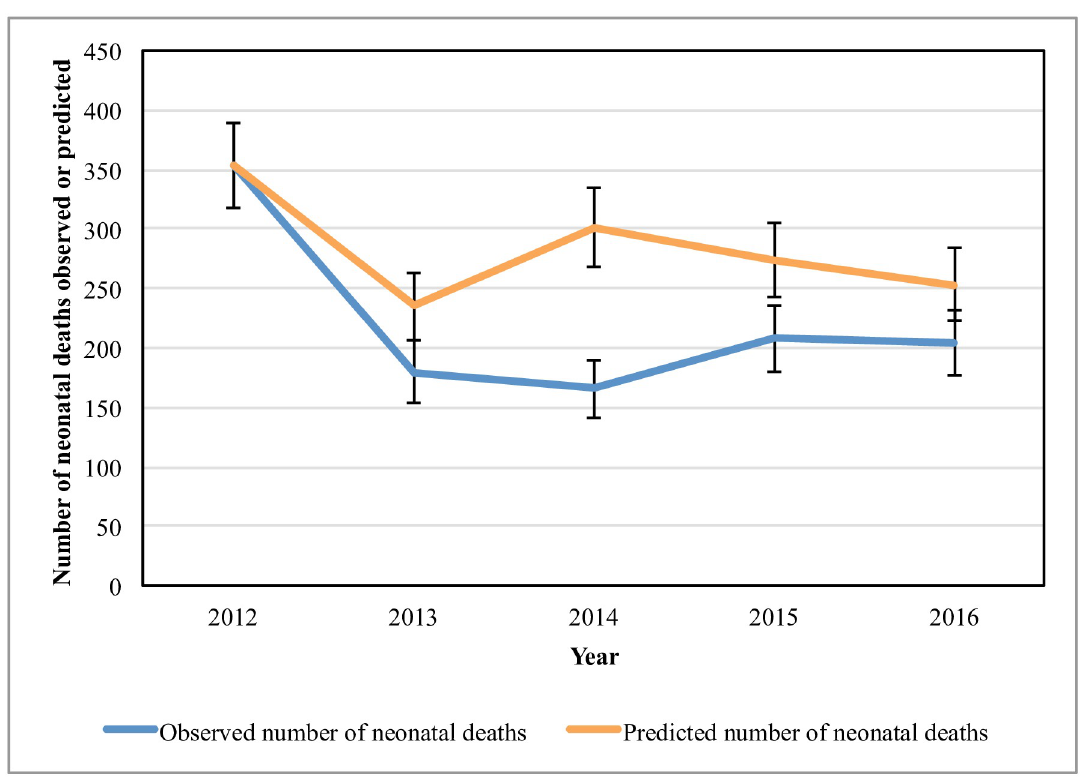
Fig 1. Neonatal deaths predicted to have occurred, by steady-state